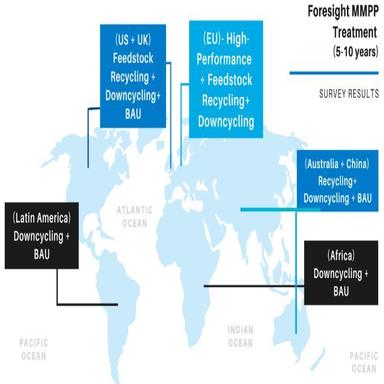
Future of MMPP recycling according to the methods assessed.